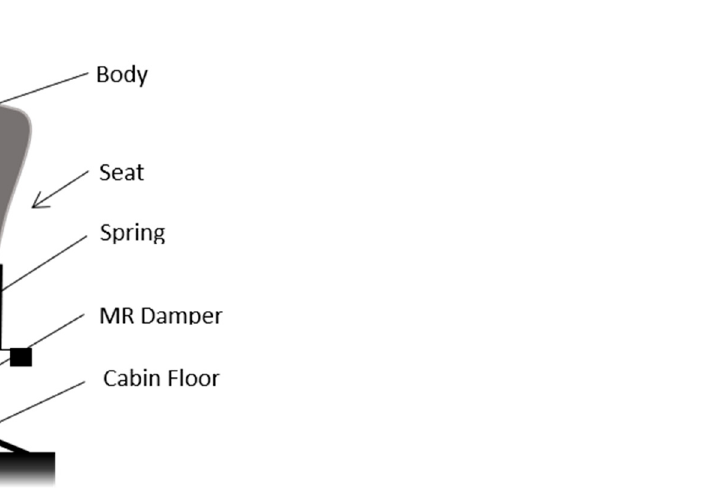
Figure 10. Physical model of the semi ‐ active seat suspension with an MR damper [37]. Reproduced with permission from Yao, H. J. et al. Semi ‐ active H ∞ control of seat suspension with MR damper; published by Journal of Physics: Conference Series, 2013.